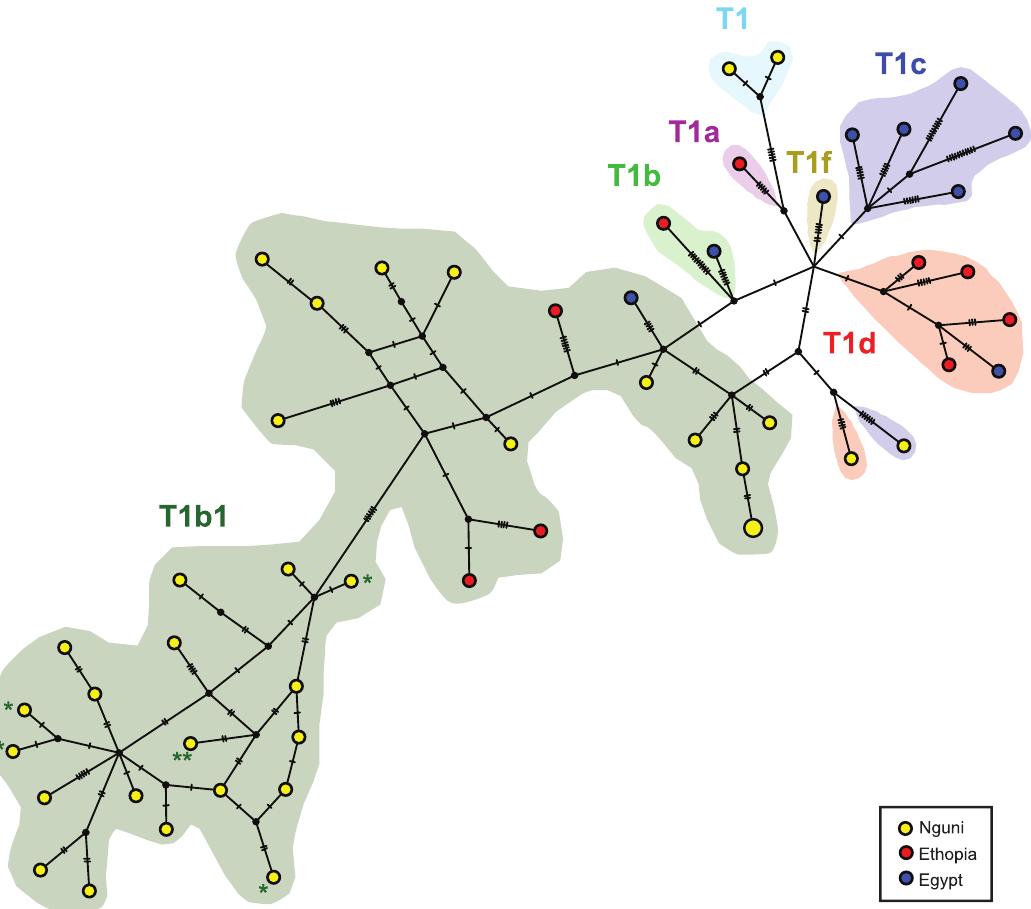
Figure 2. Median-joining haplotype network of modern cattle breeds. Ethiopia (yellow), Egypt (blue) and Nguni (red). Haplotypes are represented by circles. The number of sequences sharing the same haplotype is indicated by the numbers in the ellipses (only numbers bigger than 1 are shown). The different haplogroups were colored coded: T1 (cyan), T1a (purple), T1b (green), T1b1 (dark green), T1c (blue), T1d (red) and T1f (brown). Ethiopian and Egyptian sequences are from Bonfiglio et al. [12]. Nguni sequences are from this